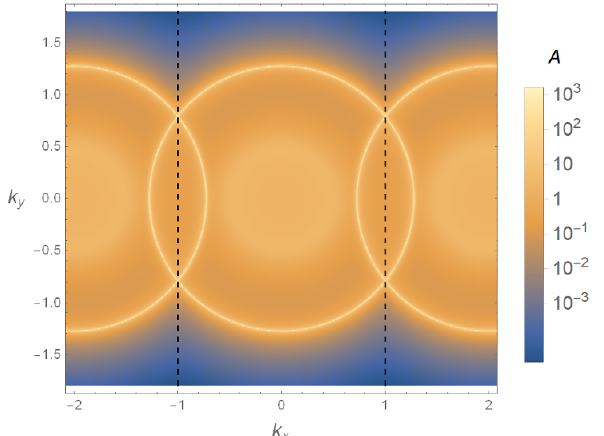
Figure 5 . The density plot of the MDF in the ( k x ; k y ) plane for q = 2 and ! = 10 (cid:0) 6 . The brightest points correspond to the location of the Fermi surface. We have used a logarithmic scale and periodically extended the data from the (cid:12)rst Brillouin zone to the other ones. The (cid:12)rst Brillouin zone boundary is denoted by the vertical dashed lines at k x = (cid:6) 1, and the background geometry has T = 0 : 01426 and k = 1.